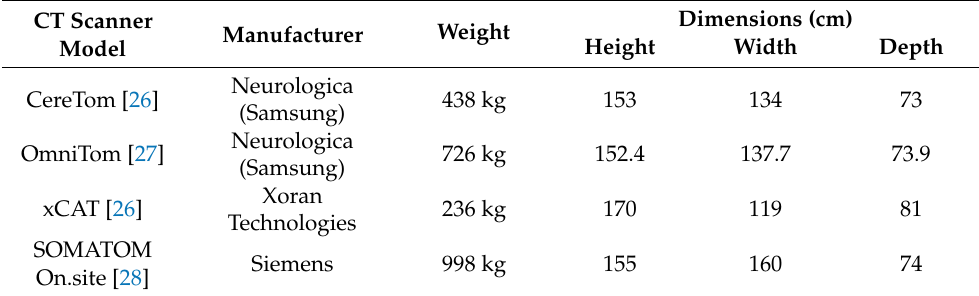
Table 1. Technical specifications of mobile head CT